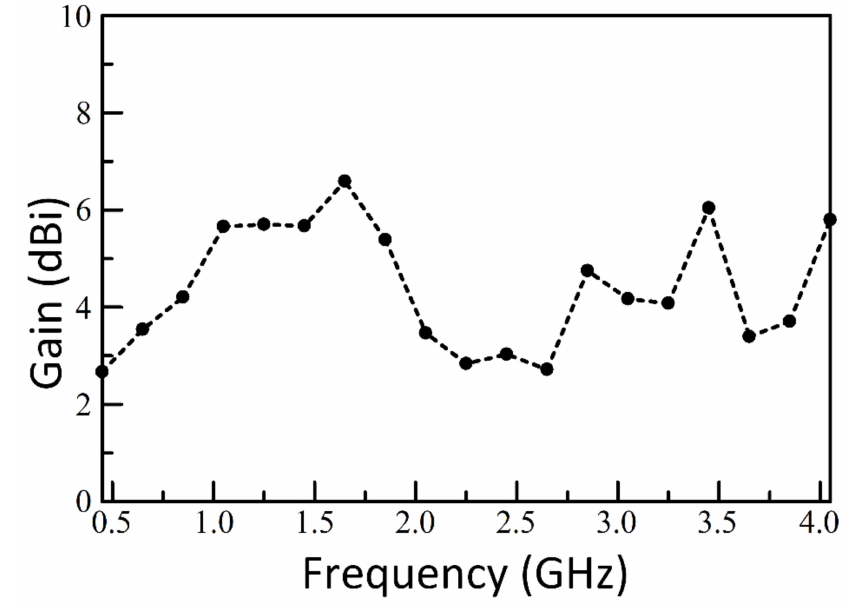
Figure 12. Simulated variation of gain with frequency multi-element